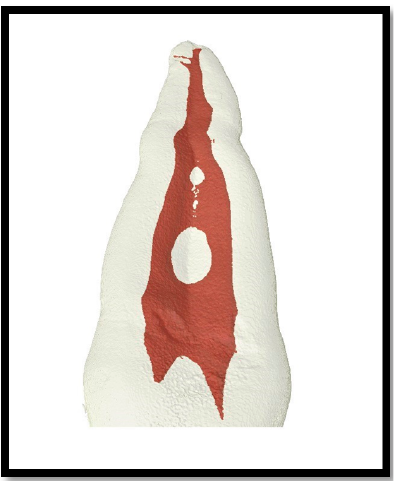
Figure 9. Micro-CT image showing the additional canal configuration (1-2-3).